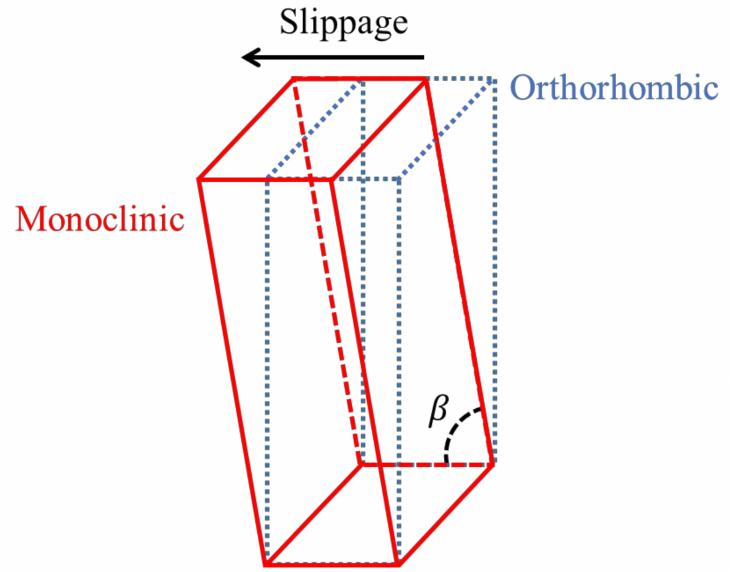
Figure 19. Schematic representation of the distortion from the orthorhombic unit cell to a monoclinic unit